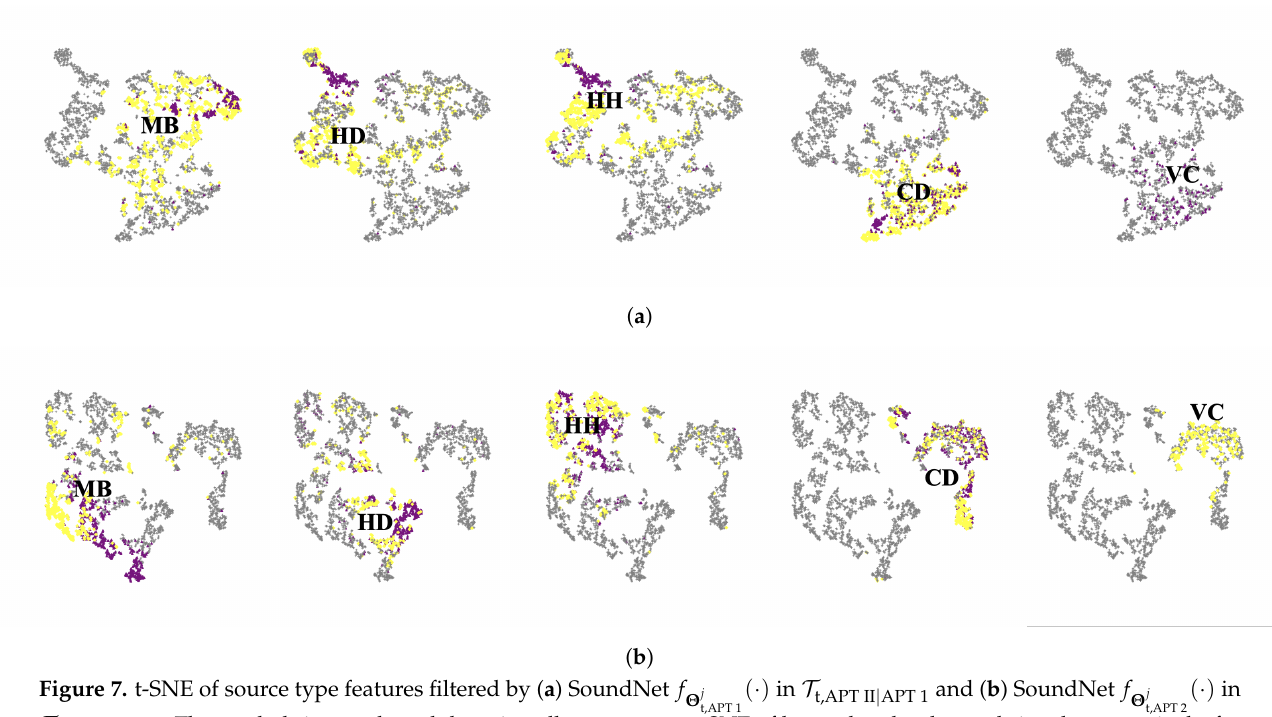
( · ) in T ( · ) in t,APT II | APT 1 and ( b ) SoundNet f Θ j t,APT1 t,APT2